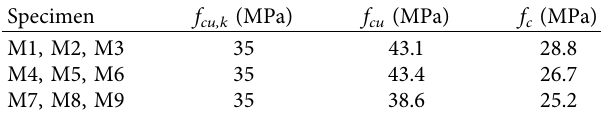
Table 1: Compressive strength of concrete (average value). Specimen